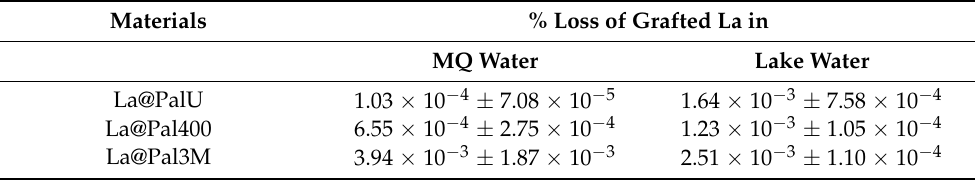
Table 3. Leaching of grated La from the modified palygorskite during P adsorption